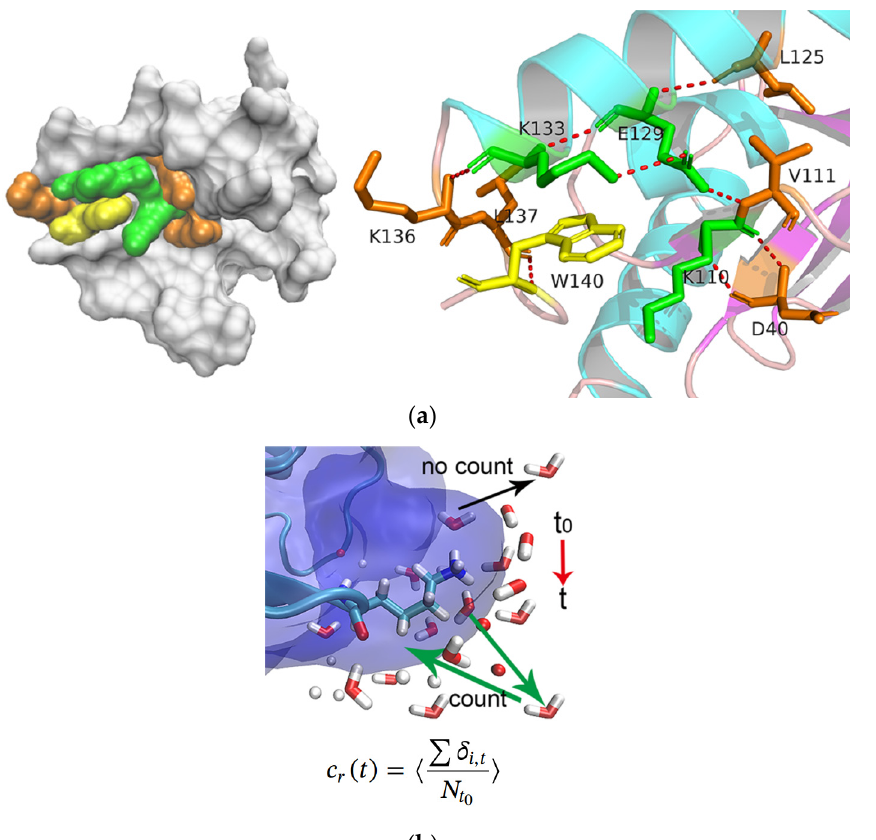
Figure 6. Analysis of residence dynamics: ( a ) the position of the selected region in protein including W140 and the three mutant residues as well as several other residues nearby, D40, V111, L125, K136, and L137; ( b ) the calculation of C r ( t ) and counting rules, where N t0 is the water molecules number in the first coordination shell at t 0 , δ i , t equals to 1 if the ith water is in the shell at time t else 0, and the angle bracket denotes the ensemble average.